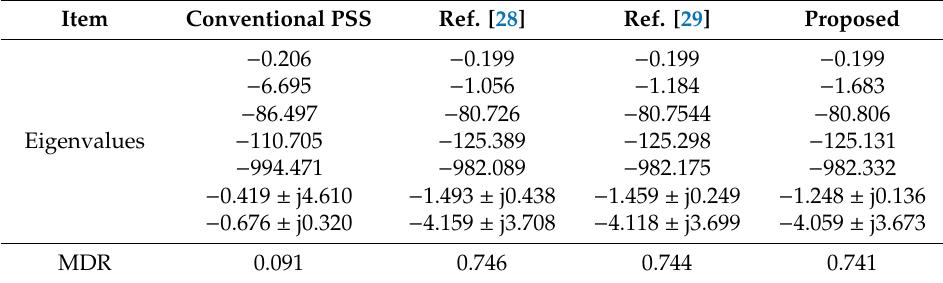
Table 11. Eigenvalues and MDR comparison for the operating situation # 4 (second network).